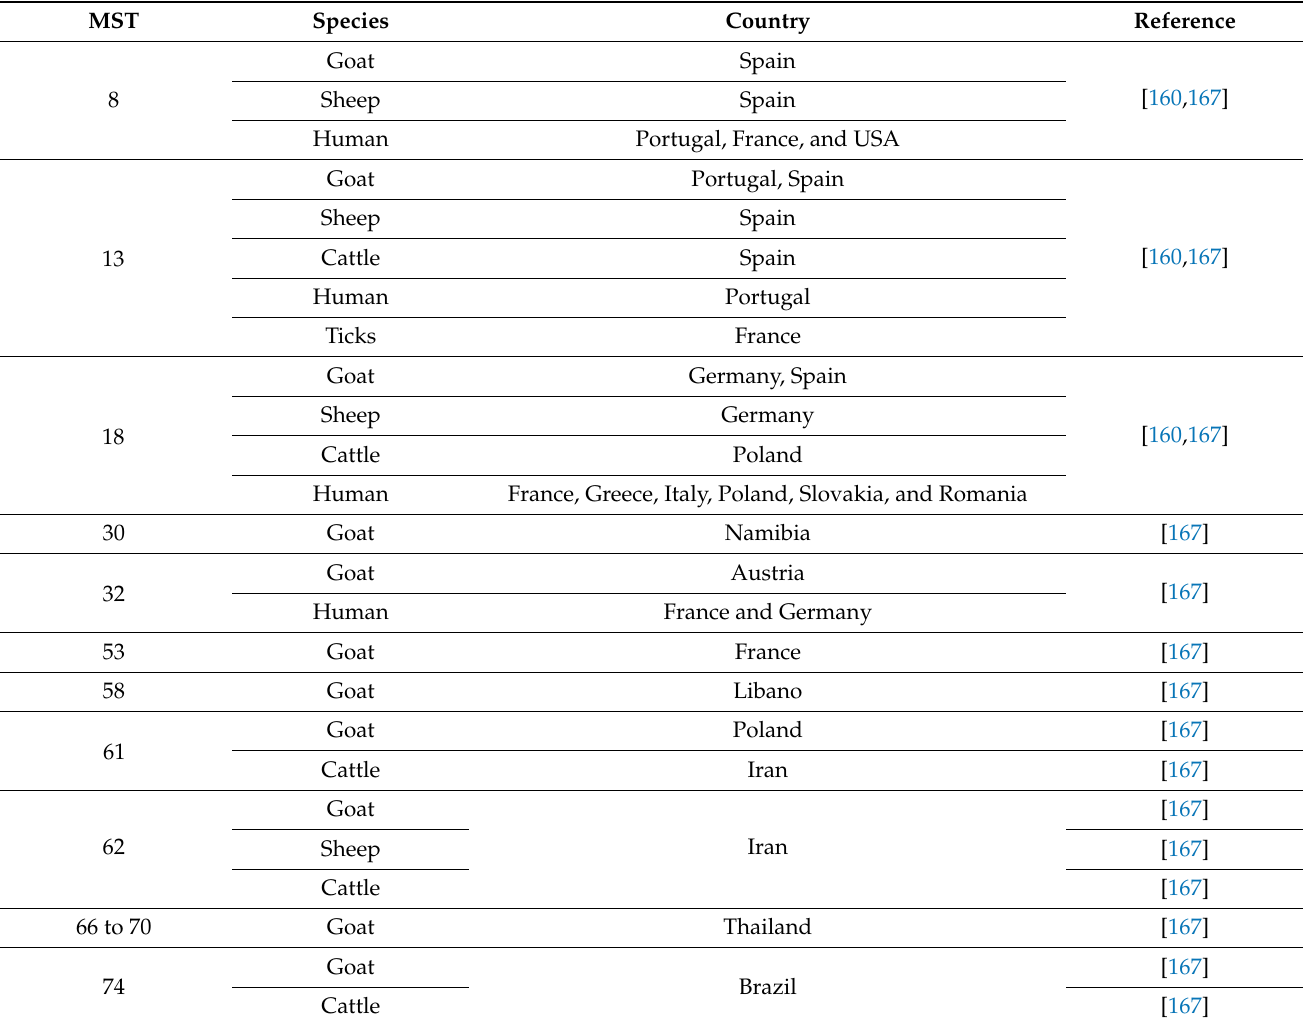
Table 5. Coxiella burnetii genotypes identified in goats and other hosts using multispacer sequence typing